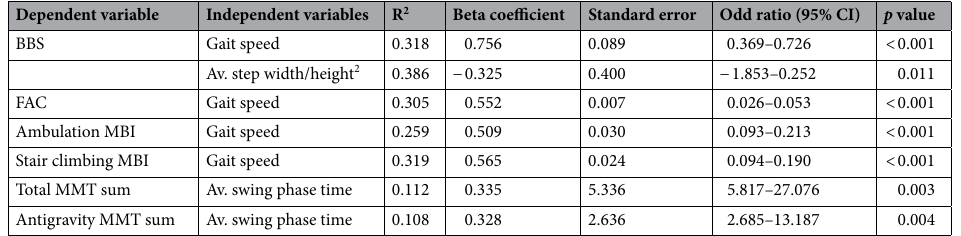
Table 3. Multiple linear regression analysis for assessing temporo-spatial parameters of gait in predicting of balance and gait function. BBS Berg balance scale, FAC functional ambulation category, MBI modified Barthel index, MMT manual muscle test, Av